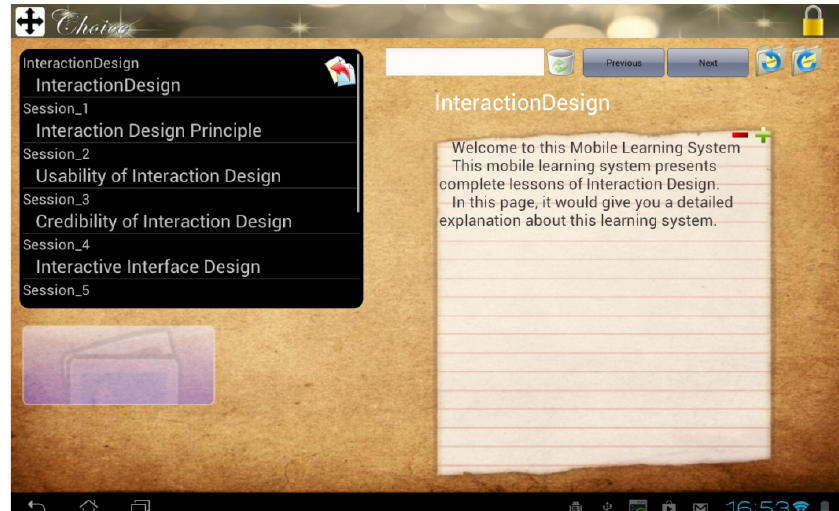
Figure 2. Customized Digital Learning System (Final